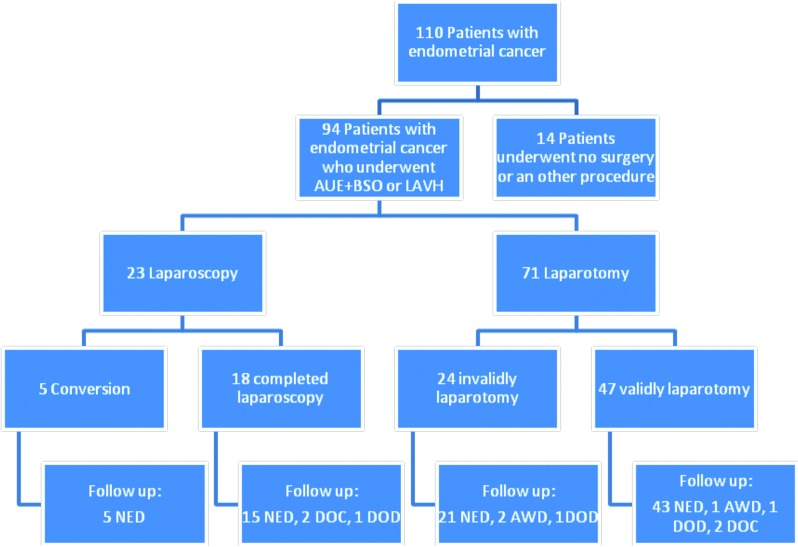
— Patient selectionThis figure shows all patients that were operated for endometrial cancer in this study. In the bottom line, the follow up of these patients is added (AUE = abdominal uterus extirpation, BSO = bilateral salpingo-oophorectomy, LAVH = laparoscopic assisted vaginal hysterectomy, NED = no evidence of disease; AWD = alive with disease; DOC = death other cause, DOD = death on disease.